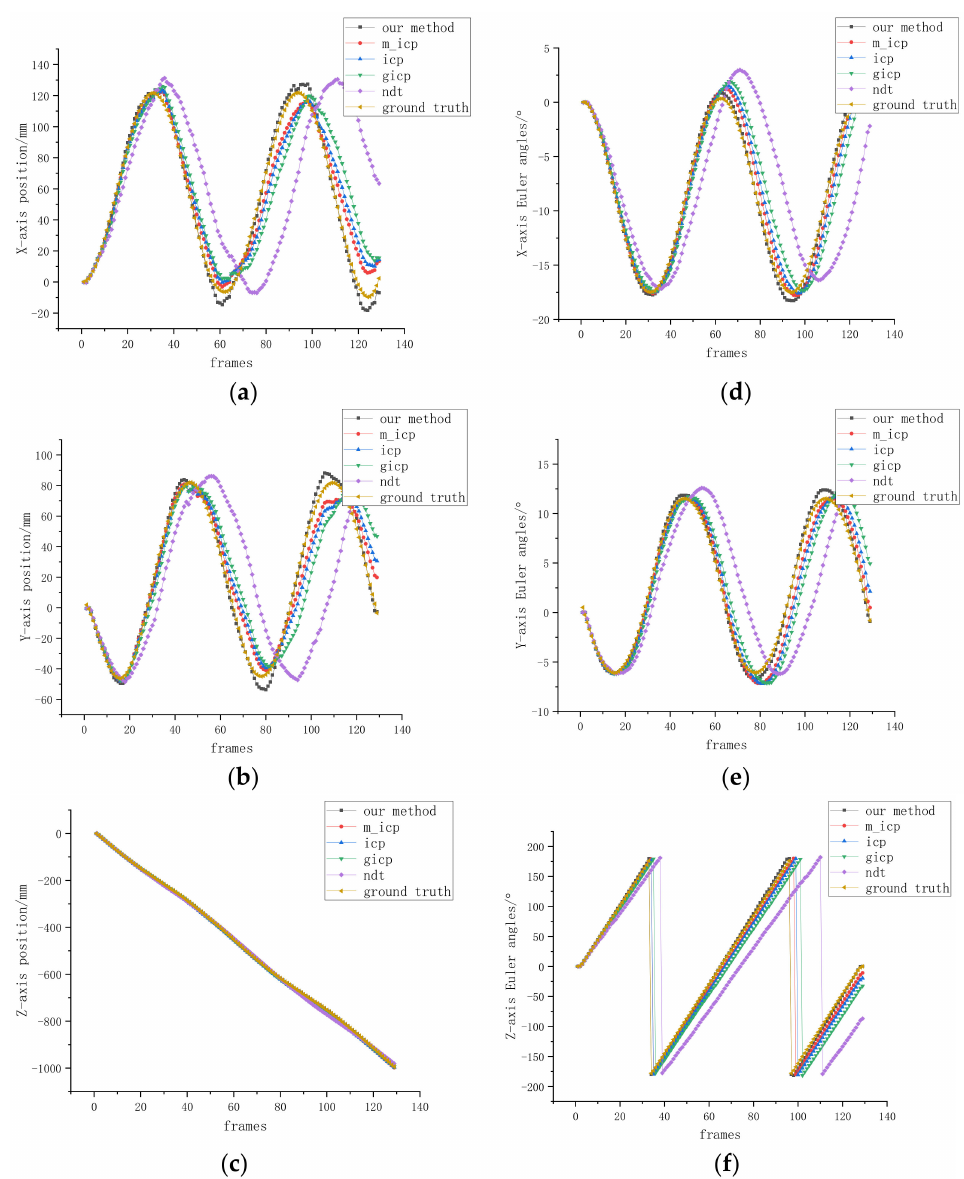
Figure 12. Comparison of pose-estimation results for the translation experiment. ( a ) X-axis translation; ( b ) Y-axis translation; ( c ) Z-axis translation; ( d ) X-axis Euler angle; ( e ) Y-axis Euler angle; ( f ) X-axis Euler